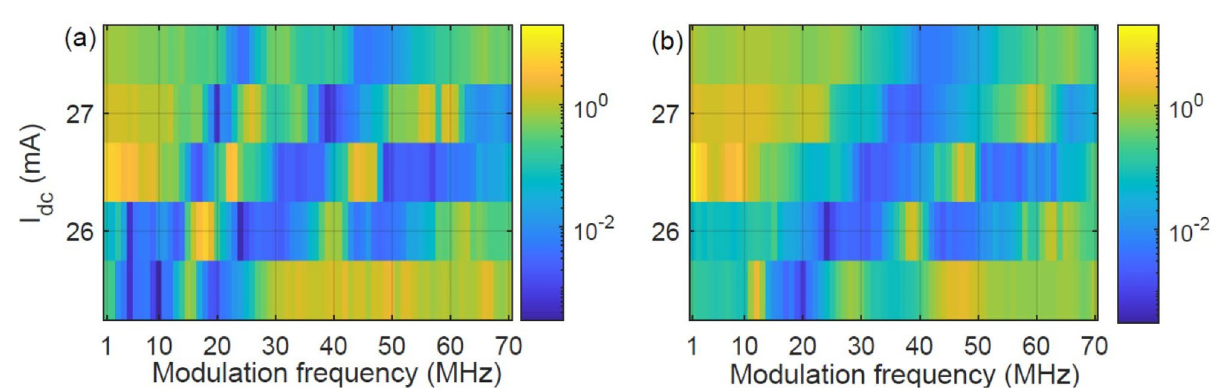
Figure 3. Fano factor (in log color code) versus the modulation frequency and the dc value of the laser current, I dc , for pulsed ( a ) and for sinusoidal ( b ) modulation. The blue region located at low frequencies in panel ( a ), where the spikes are 1:1 locked to the modulation is not seen in panel ( b